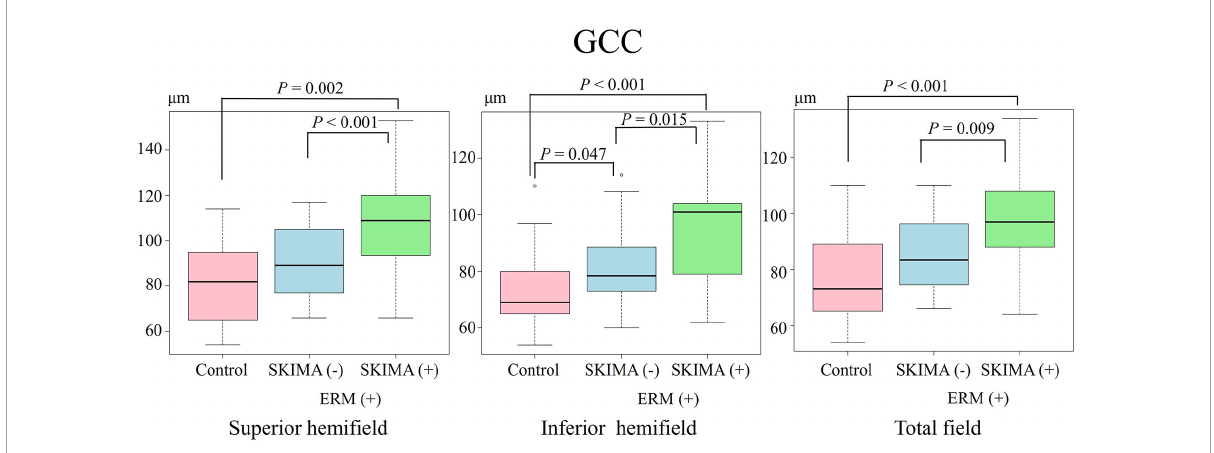
FIGURE4 Effect of SUKIMA on GCC thickness. Superior hemifield (Left panel) significant difference was found between SUKIMA (+) and control groups and between SUKIMA (+) and SUKIMA ( − ) groups. Inferior hemifield (Middle panel) significant difference was found between each group. Total field (Right panel) significant difference was found between the SUKIMA (+) and control groups and between the SUKIMA (+) and SUKIMA ( − ) groups.